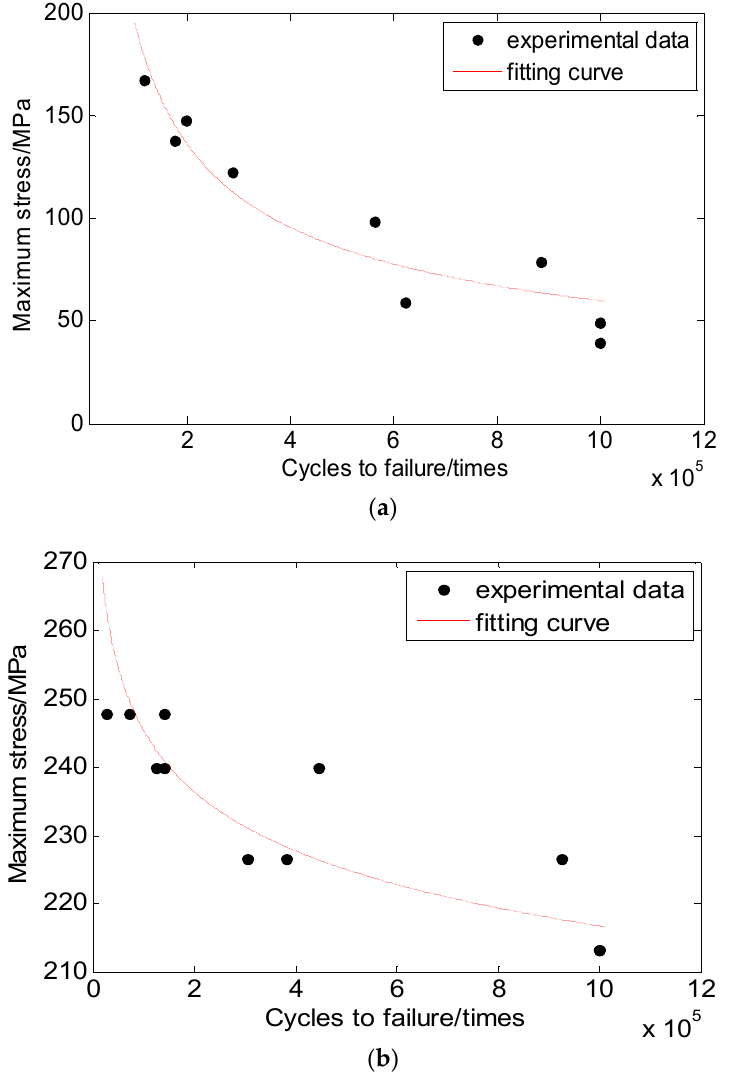
Figure 7. S-N curve in the principal direction at 600 °C. ( a ) S-N curve of tensile-tensile R = 0.1 constant amplitude fatigue loading; ( b ) S-N curve of compressive-compressive R = 10 constant amplitude fatigue loading.